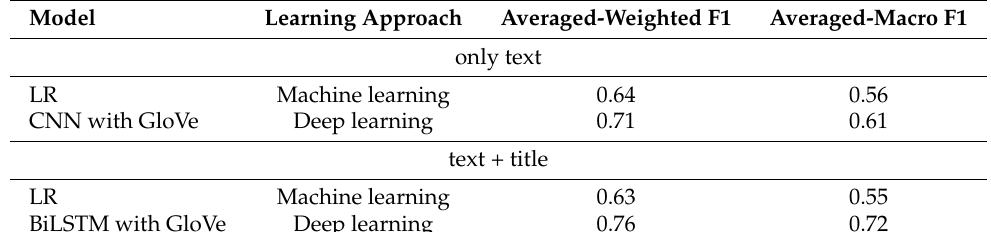
Table 5. Previous state-of-the-art results on regret detection.